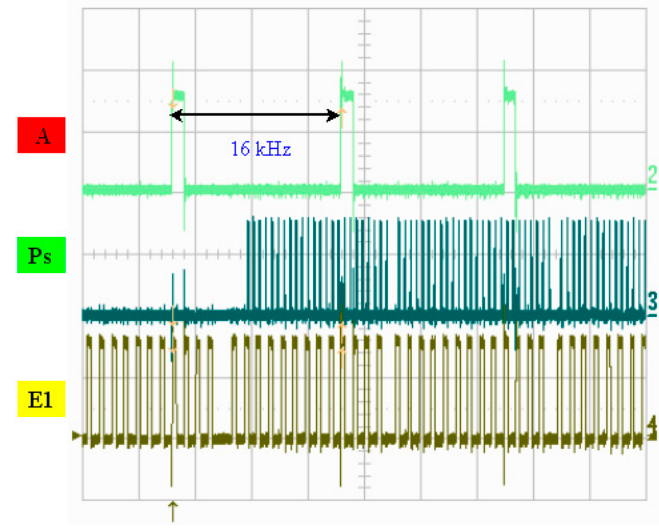
Figure 12. Frequency testing: best mode.